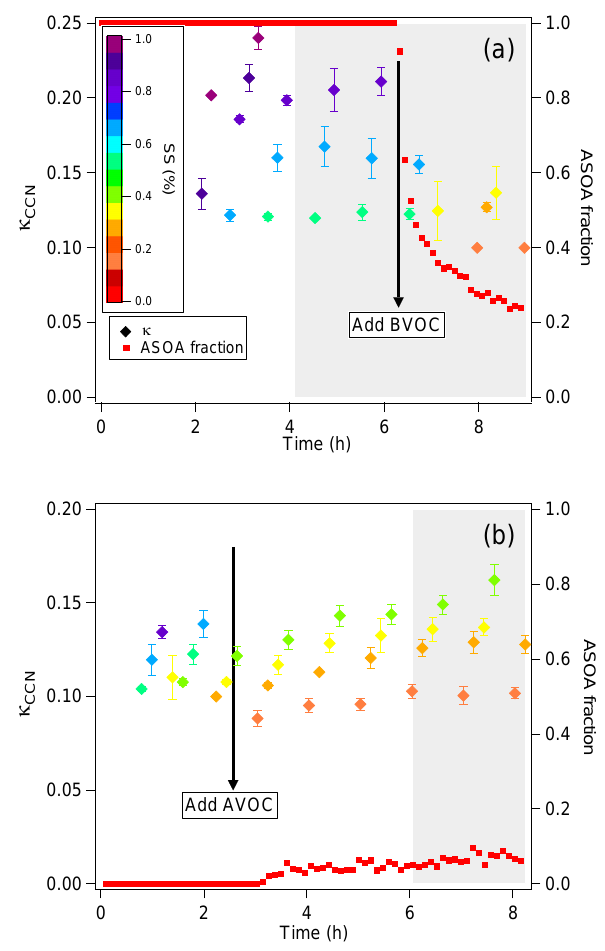
Figure 2. CCN activity of ABSOA from sequential VOC addition at various supersaturations (SS). (a) Toluene was added first and monoterpenes were added 6 h afterwards as indicated by the vertical arrow. The shaded areas show dark periods. ASOA fraction (red dots, right axis) decreased remarkably upon BVOC addition but κ CCN showed no significant change. (b) Monoterpenes were added first and toluene was added 2.6h afterwards as indicated by the vertical arrow. κ CCN showed no significant change upon the ad- dition of AVOC to BSOA. Note that time series of κ CCN should be followed at similar SS because κ CCN depended on SS and the SS range may change due to the particle size change.